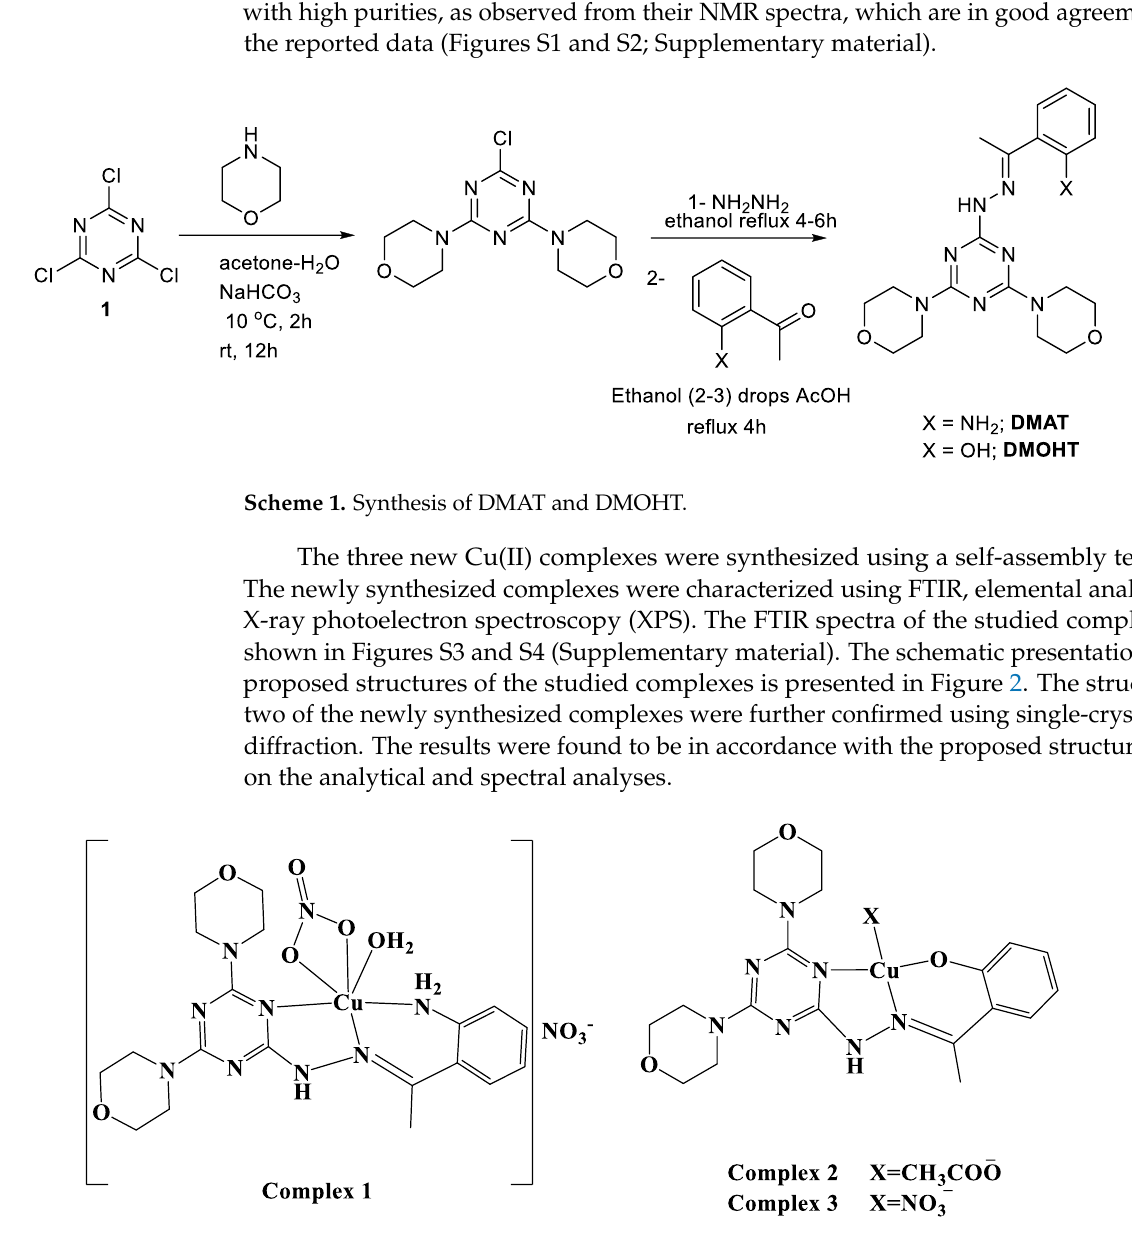
Figure 2. Structures of the synthesized Cu(II) complexes.